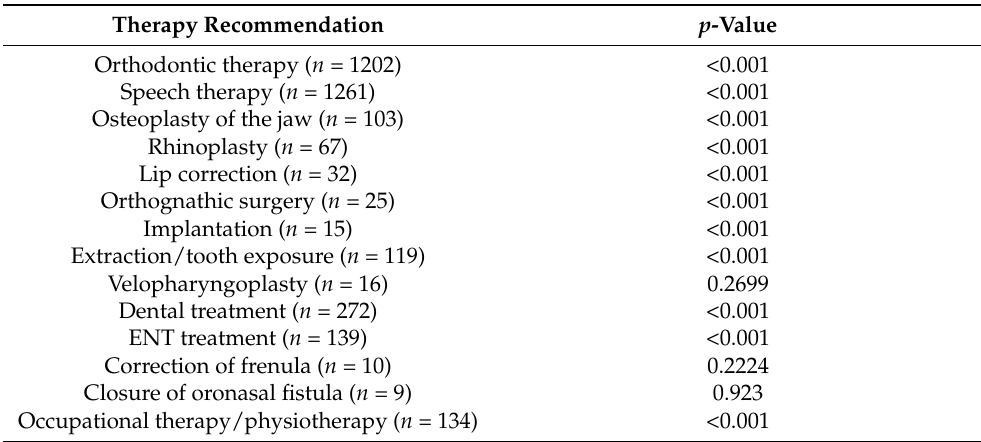
Table 2. p -values resulting from chi-square test and Fisher’s exact test for the association between age and therapy